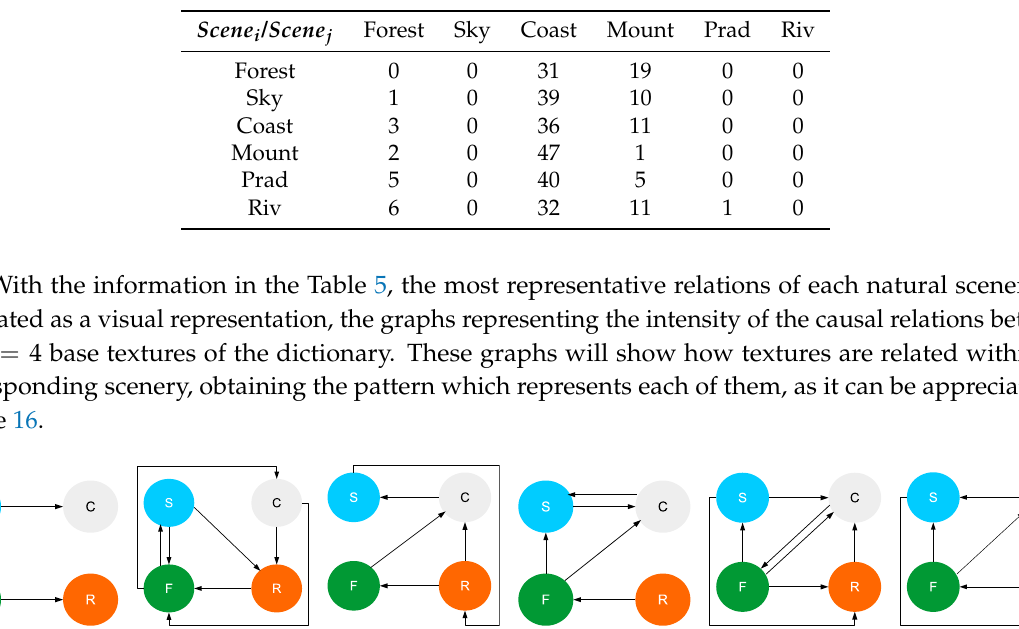
Table 6. Confusion matrix for a test with 50 images per scenery, using a manual selection of causal relationships.